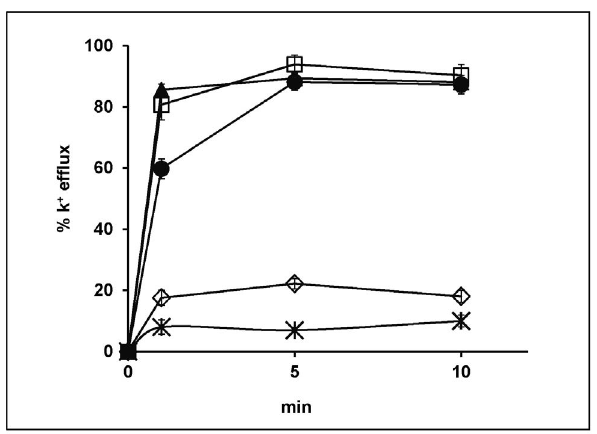
Figure 5. Dose-dependent effect of FG08 on cellular K + efflux by S.cerevisiae strain W303. Cells growing in YPD medium were N washed and suspended in 10 mM HEPES-NaOH buffer, pH 6.5, 25 mM ), 50 ( % ) or 100 ( m ) m g glucose with FG08 at concentrations of 20 ( mL 2 1 or kanamycin B at 50 m g mL 2 1 ( e ). Controls ( 6 ) were not treated with FG08 or kanamycin B. Error bars represent data compiled from three separate experiments.